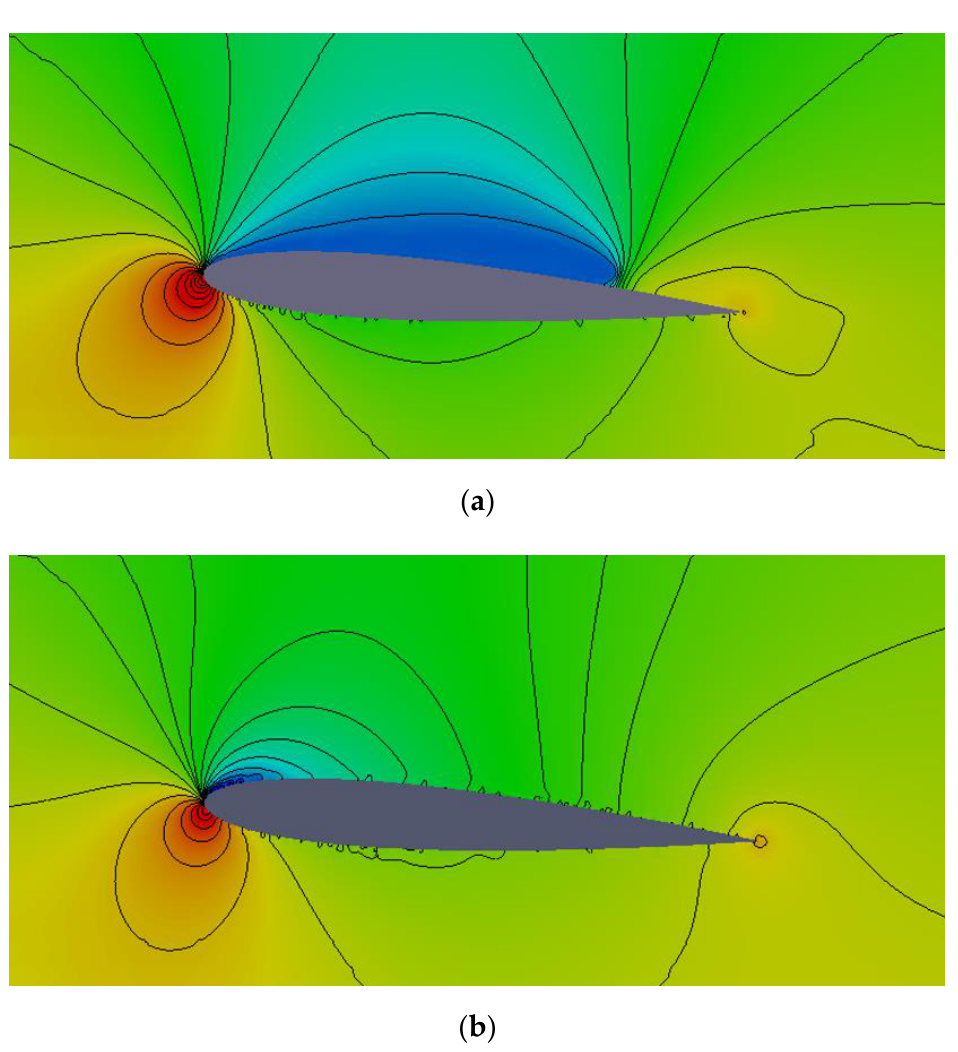
Figure 6. Contrast between the pressure distributions of the cavitating and non-cavitating flows. ( a ) Pressure distributions of the cavitating flows. ( b ) Pressure distributions of the non-cavitating flows. The two-dimensional cloud cavitation phenomena of NACA0012 hydrofoil in a uni- form flow field at 4 and 8-degree of attack and under 0.8 cavitation numbers were studied and compared with the experimental results. The calculated cavitation shape and vapor con- tent were shown in Figures 7 and 8. In Figure 7, the angle of attack of the two-dimensional hydrofoil is 4 degrees, and in Figure 8, the angle of attack is 8 degrees. The numerical results of three different turbulence models are given. It can be seen that the cavitation flow was unsteady. Different stages of cavitation, such as growth and collapse, were